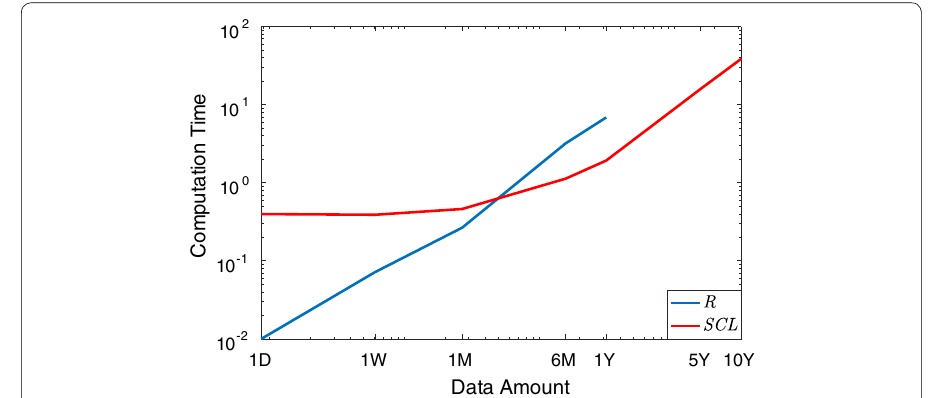
Fig. 4 Computation time required for training a MLR using different amounts of